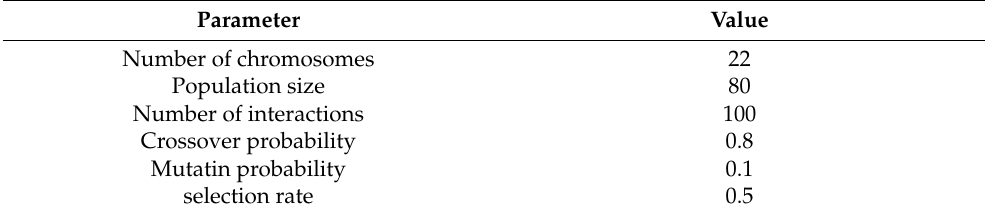
Table 4. Parameters of the genetic